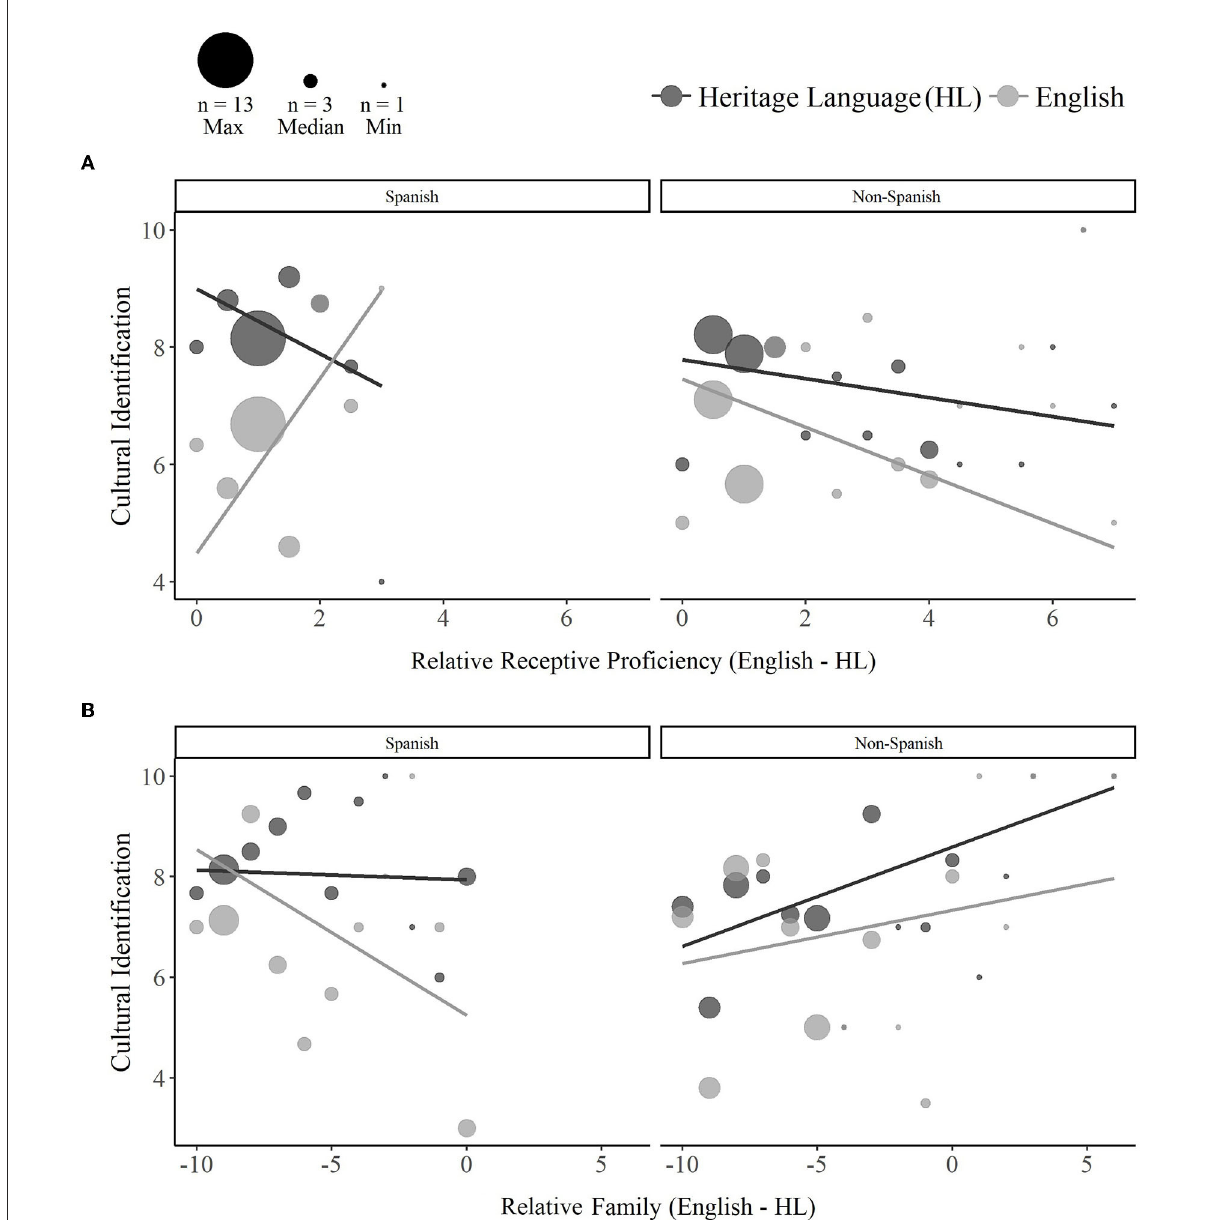
FIGURE6 Effects of relative language experience (English—HL) on cultural identification with the HL (dark gray) and English (light gray). Among Spanish bilinguals, cultural identification with English increased with higher relative English (vs. HL) receptive proficiency (A) . Relatively higher ratings of English (vs. HL) acquisition and exposure through family was associated with lower English identification among Spanish bilinguals and marginally higher HL identification among non-Spanish bilinguals (B) . Dot sizes reflect the number of participants contributing to each aggregated value (max = 13, median = 3, min =